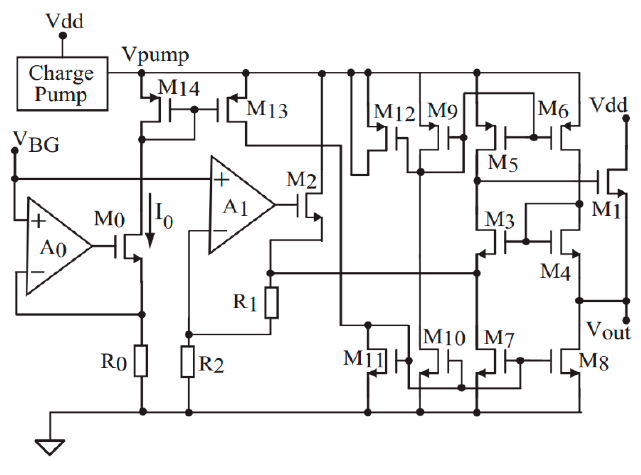
Figure 12. The LDO with compact output driver [23].